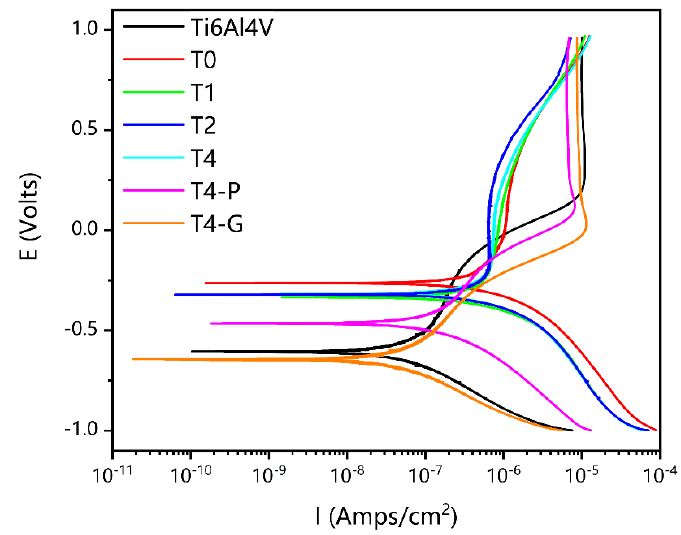
Figure 10. The images of the polarization curves in Hank’s solution. The I corr , E corr , and corrosion rates of different samples are shown in Table 3. The non-mechanically treated samples after nitriding had a more pronounced passivation zone at I = 10 − 6 A/cm 2 . However, the untreated samples and the T4-P and T4-G samples had the passivation zone around I = 10 − 5 A/cm 2 . The trends of the polarization curves of the T4-P and T4-G samples were similar. It is presumed that the surface of all these samples formed an oxide film of Ti. For the nitriding samples without mechanical treatment, the polarization curves were basically the same. The TiN layer on the surface, instead of the oxide layer, acted as a good barrier and alleviated the corrosion level of the substrate [58]. It can be further demonstrated that a small amount of TiN phase on the sample surface of T0 was not detected by XRD. In terms of self-corrosion currents, the untreated T2 and T4 samples have approximated I corr values. However, the I corr values of the mechanically treated samples were all elevated to different degrees. This is due to the loss of the corrosion inhibition mechanism of the TiN layer. In addition, the nitride of Ti and α -Ti(N) interstitial solid solution prevented the formation of the oxide layer to some extent. In nitriding samples at different times, I corr and nitriding time were negatively correlated, which was directly related to the thickness of the nitriding layer. Both sufficient TiN layer and oxide layer can reduce the I corr of the substrate, but when the nitride layer is too thin, or the barrier effect of the oxide layer is weakened due to the influence of N elements, the I corr will be reduced. All E corr values of the samples were ranked from smallest to largest as T4-G < Untreated Ti6Al4V < T4-P < T4 < T2 < T1 < T0. For E corr , the nitride of Ti plays a dominant role.